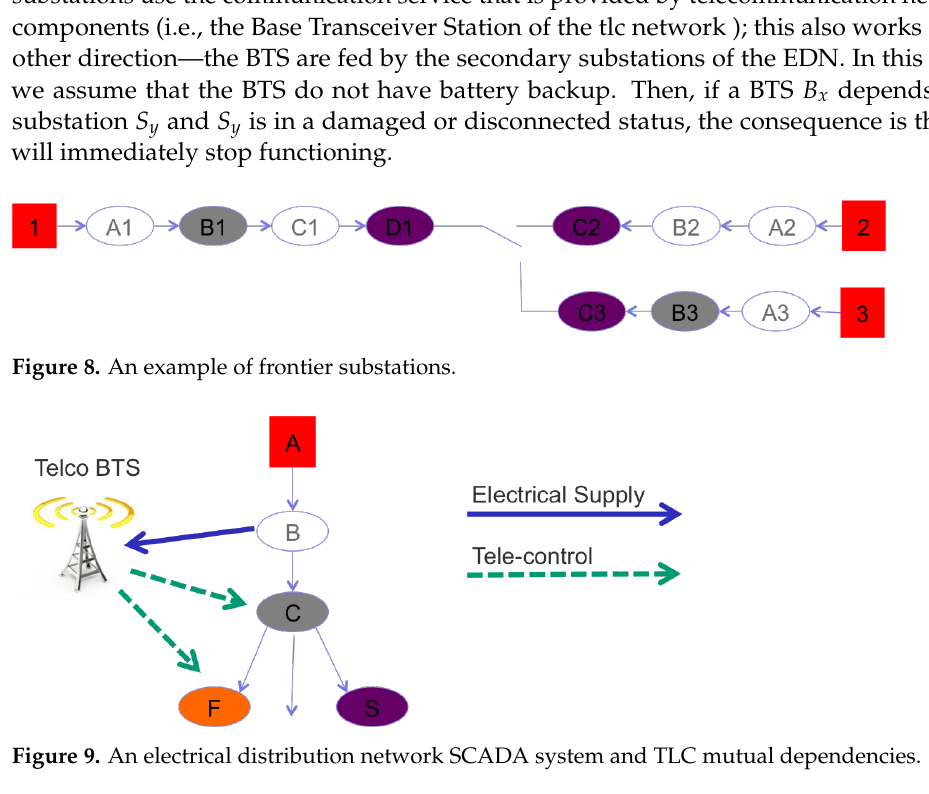
Figure 9. An electrical distribution network SCADA system and TLC mutual